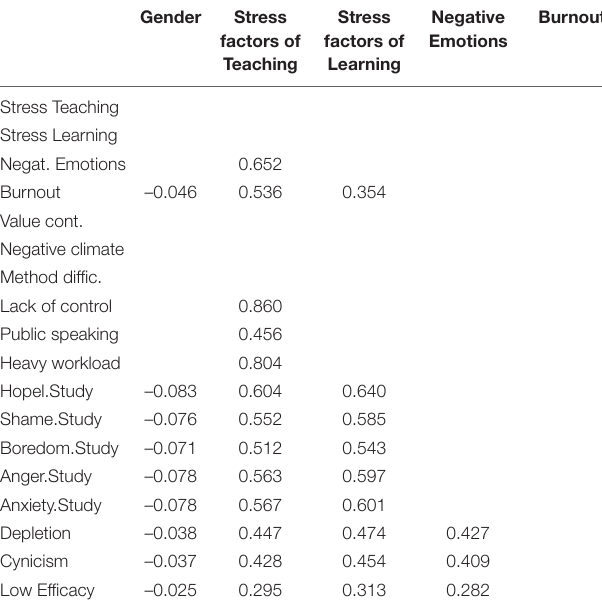
TABLE 3 | Standardized Indirect Effects of